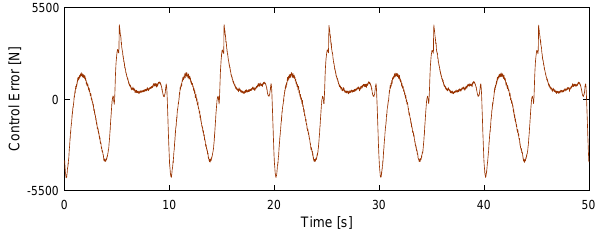
Figure 19: Performance in the presence of velocity